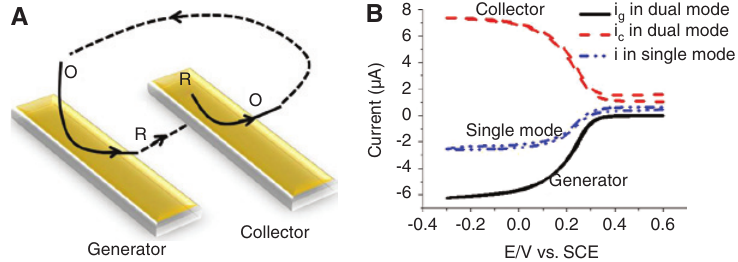
Figure 5: (A) Illustration of the redox cycling process that occurred in generator-collector working mode for double electrode systems (taking oxidant as initial species); (B) Cyclic voltammograms of plane-recessed MEAs in generator-collector mode and single mode. In the generator-collector mode, the generator is swept at 10 mV/s, while the collector is held at 0.6 V. In the single mode, the generator is swept at 10 mV/s and the collector electrode is left floating. Solution: 6 mm K